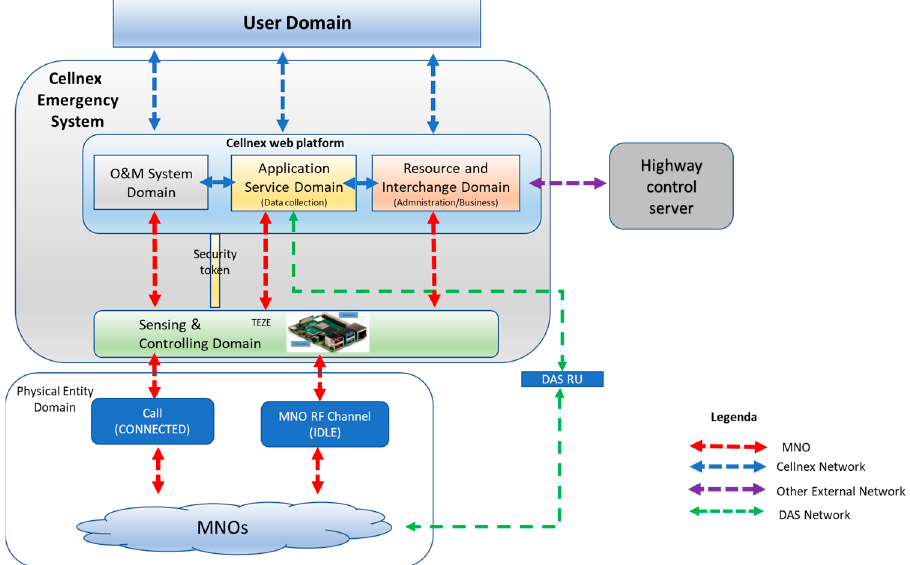
Figure 5. TEZE system domain-based reference model.